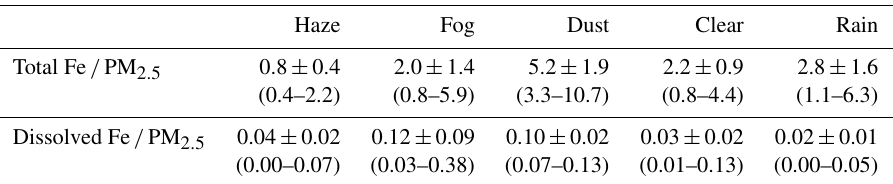
Figure 1. The box-and-whisker plot of the concentrations of total Fe (a) , dissolved Fe (b) , and Fe solubility (c) under haze, fog, dust, clear, and rain conditions. The solid circles above and below the box show the maximum and minimum values, respectively. Table 1. Percentage contributions of total Fe and dissolved Fe concentrations to PM 2 . 5 concentration under haze, fog, dust, clear, and rain conditions. The maximum and minimum values are in